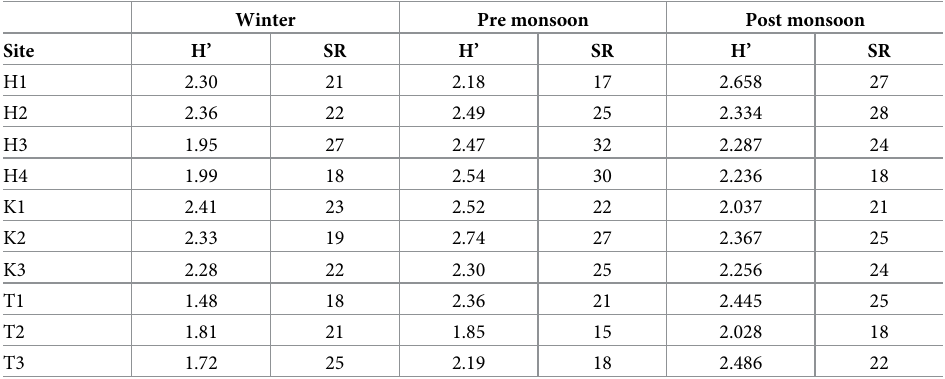
Table 4. Details of diversity (H’) and richness (SR) for sampling locations during seasonal sampling periods in Madhya